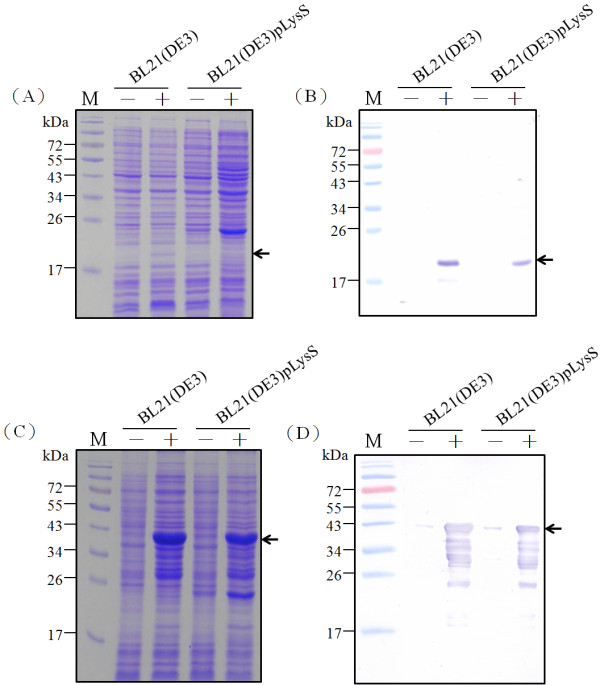
Expression of recombinant TAT-Apoptinoptprotein in the differentE. colistrains. The TAT-Apoptinopt protein was expressed in the E. coli strains BL21(DE3) and BL21(DE3)pLysS, which contained either pET-TAT-VP3opt or pGEX-TAT-VP3opt, at 37 °C. His-TAT-Apoptinopt and GST-TAT-Apoptinopt protein were examined and detected using SDS-PAGE (A, C) and Western-blotting (B, D). Anti-His and anti-GST tag monoclonal antibodies was respectively used to recognize the His-TAT-Apoptinopt protein and GST-TAT-Apoptinopt. Lane M, pre-stained protein marker; “-” and “+” represented pre-induction and post-induction with 1 mM of IPTG over 4 hrs of cultivation in E. coli, respectively.